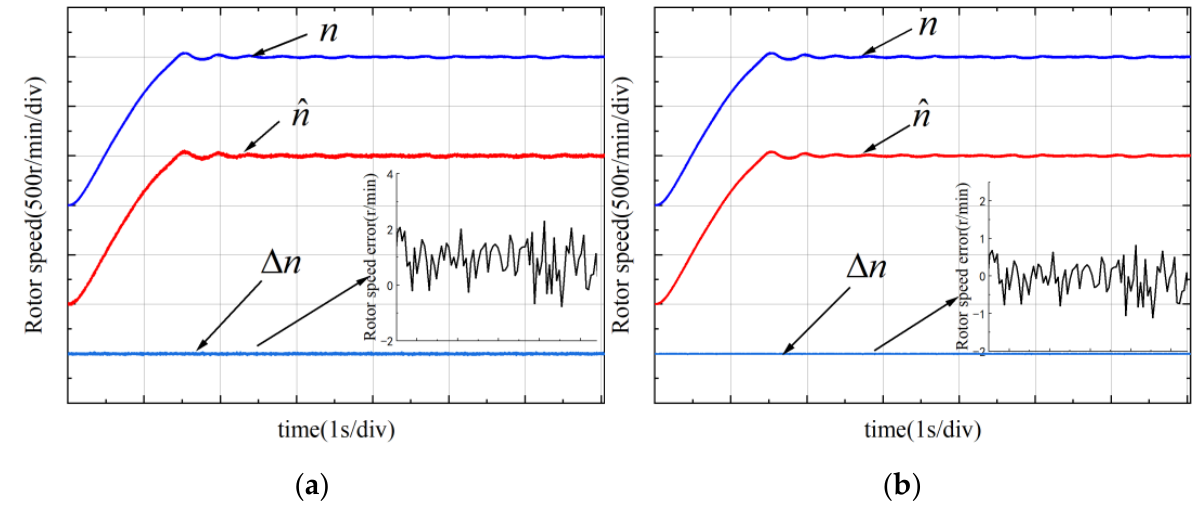
Figure 20. Rotor speed experimental results: ( a ) traditional SMO; ( b ) improved SMO.